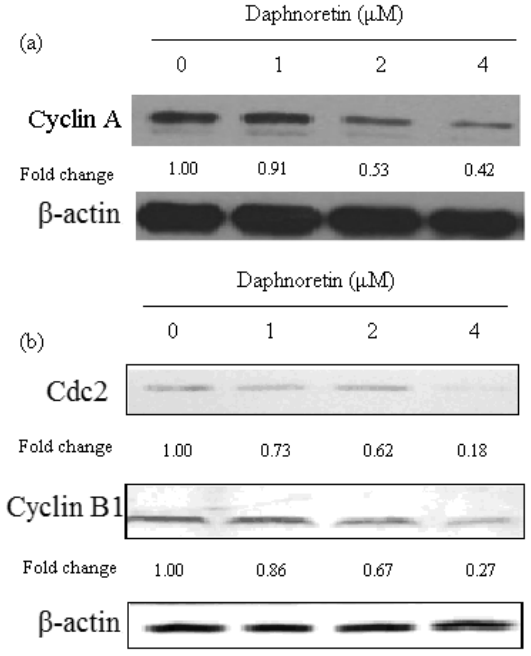
Figure 6. Immunoblotting for the expression of cell cycle-regulating proteins (a, cyclin A; b, cdc2 and cyclin B1) in response to treatment with daphnoretin (0, 1 µM, 2 µM and 4 µM) for 48 h. The blots were stripped and reprobed with anti- β -actin antibody to normalize protein loading. Fold change was calculated as described in Figure